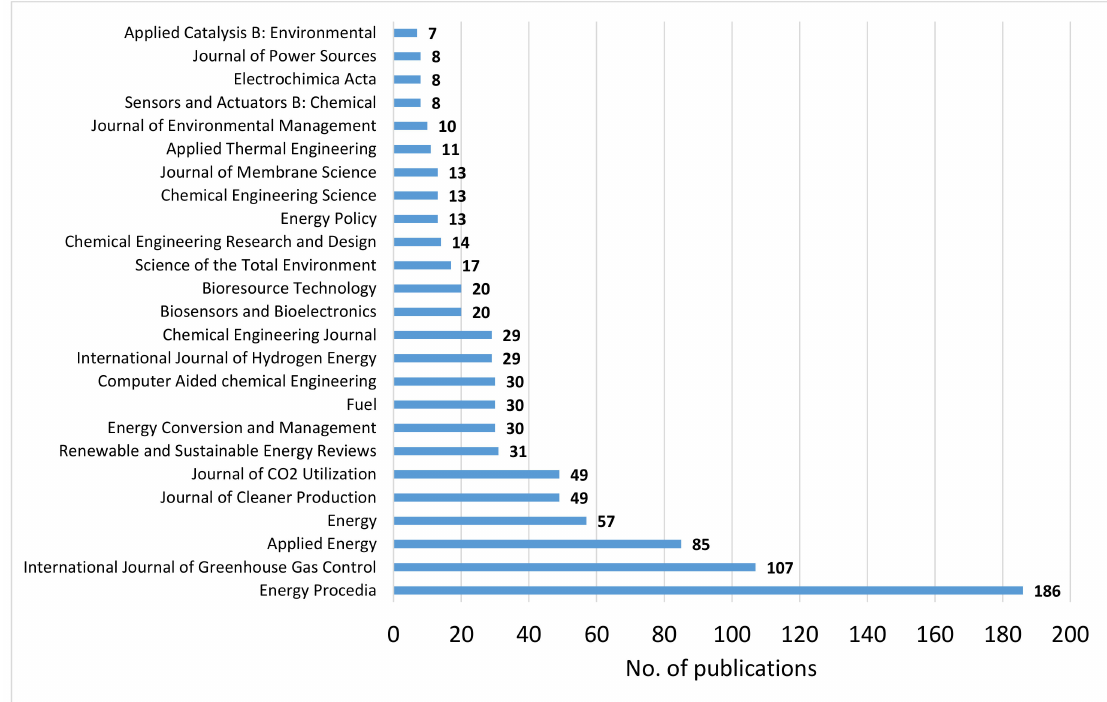
Figure 4. Number of articles for the most popular academic